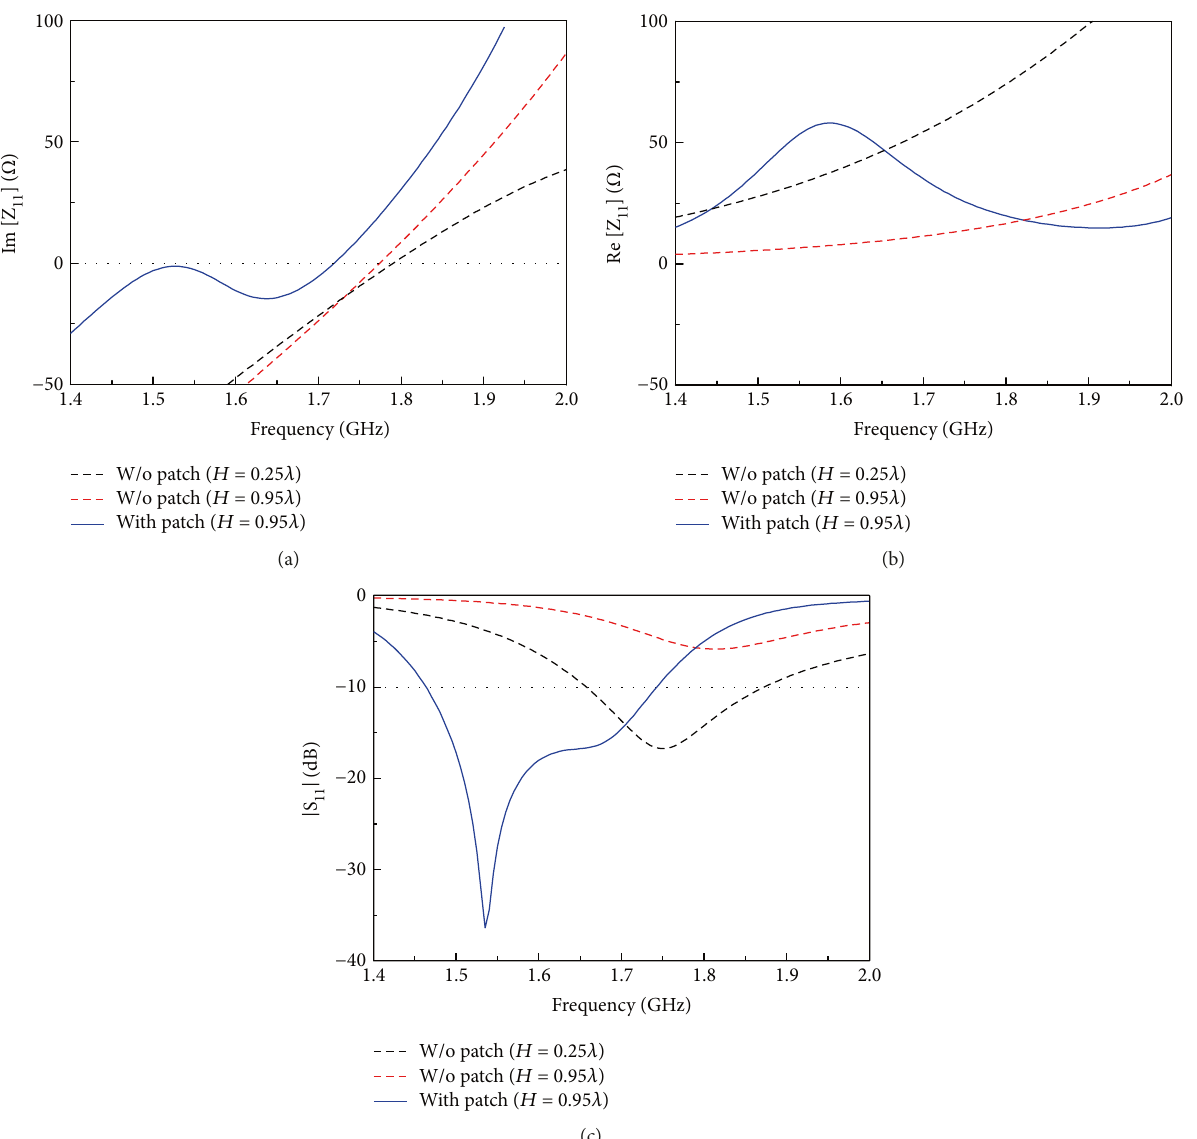
Figure 2: Simulated (a) imaginary part of Z ( λ is the free-space wavelength at